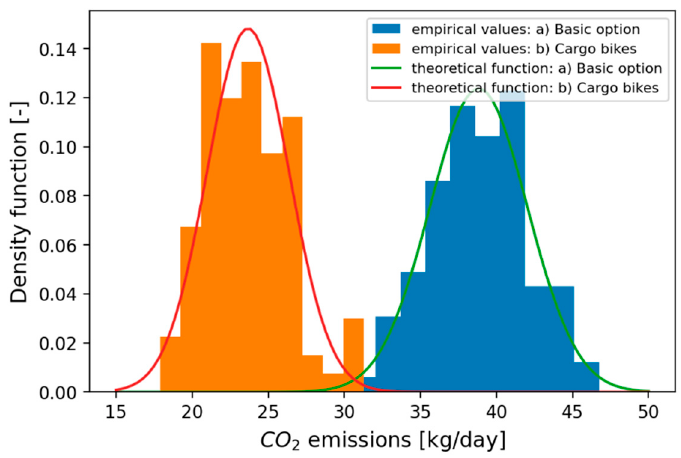
Figure 9. Distribution of the CO 2 emissions based on the results of simulations for Mechelen.